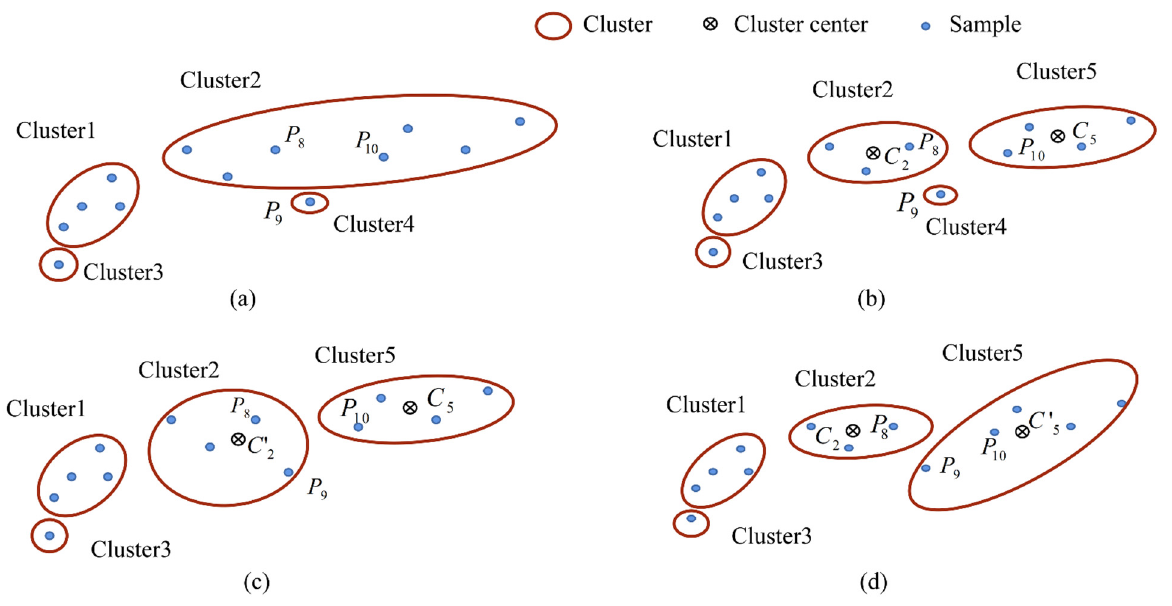
Figure 3. Clustering process of MNNC: ( a ) clustering result of training samples; ( b ) division of the cluster with discontinuous sample label into independent clusters; ( c ) Cluster 4 is merged into Cluster 2; ( d ) Cluster 4 is merged into Cluster 5. Algorithm 1. MNNC.